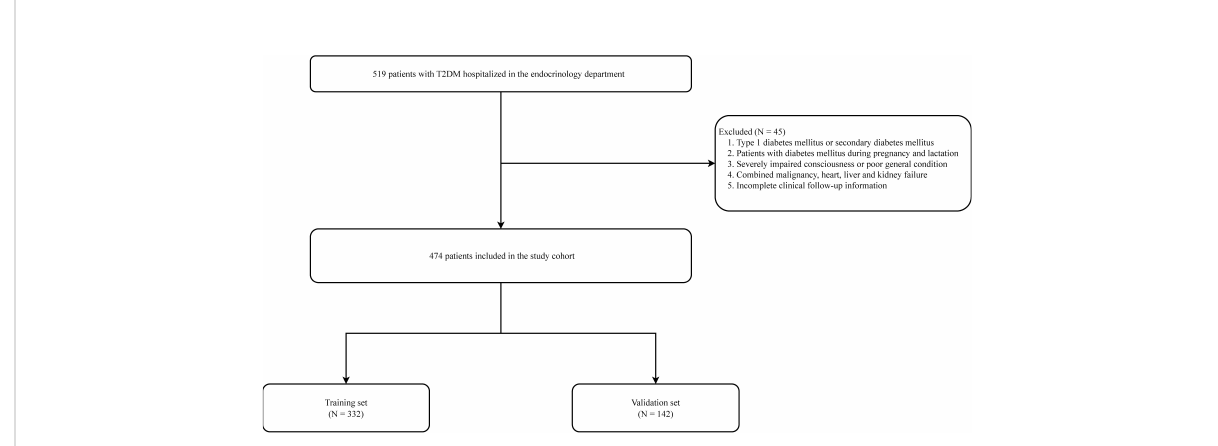
FIGURE 1 Flow chart for peripheral artery disease in patients with type 2 diabetes mellitus